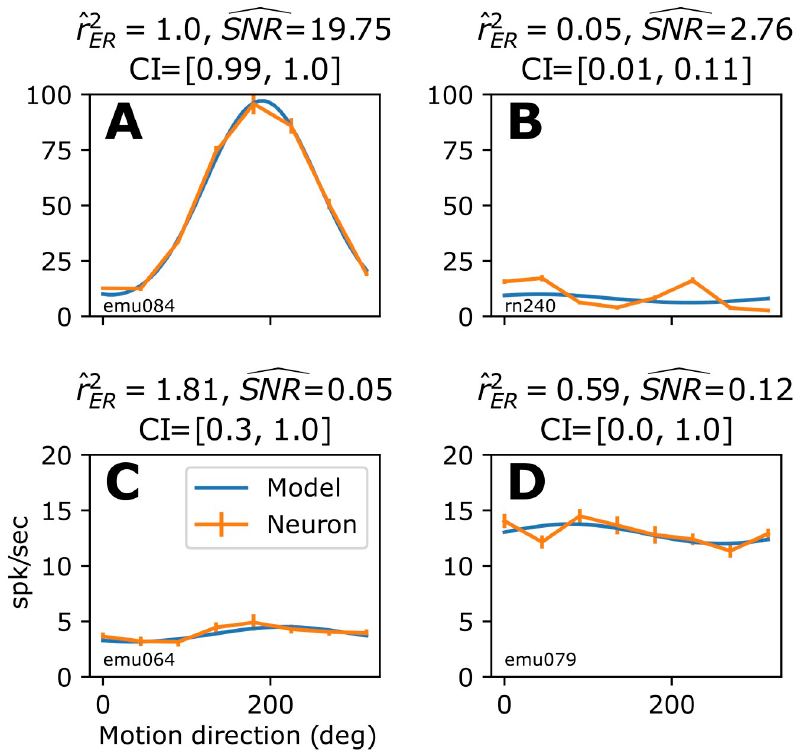
Fig 7. Applying our unbiased estimator with CIs to fit four example MT neuronal direction tuning curves to a sinusoidal model. (A) Example neuron tuning curve (orange trace with SEM bars) with excellent fit to sinusoidal ¼ 1 : 0 ), high SNR and tight CI (parameters specified above plot panel). (B) Example neuron model (blue trace, ^ r 2 ER with poor fit to sinusoidal model but with a reasonable SNR and narrow CI that provide confidence that the neuronal tuning systematically deviates from the model. (C) Example neuron with poor SNR and wild estimate of ^ r 2 , which is ER reflected in large CI = [0.3, 1], suggesting that no conclusion can be made about how well the model describes any actual tuning here. (D) Example neuron with a seemingly reasonable ^ r 2 , but the low SNR and CI covering the entire ER interval [0, 1] reveals that this fit cannot be trusted.